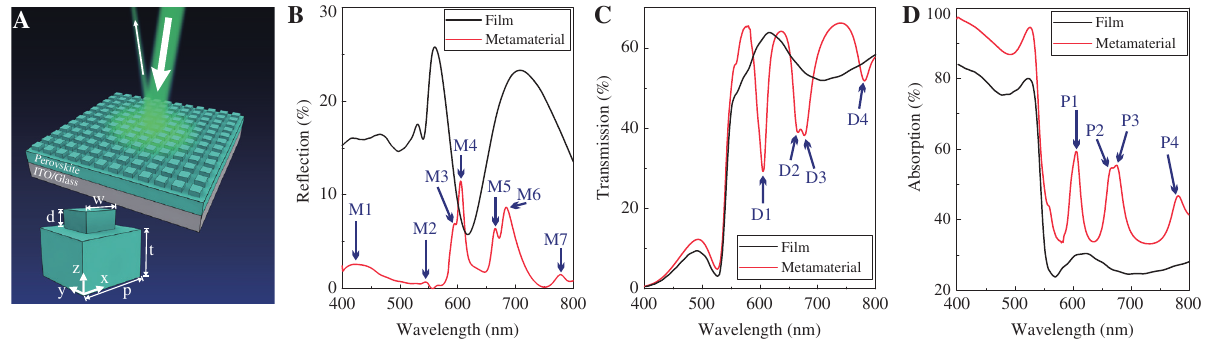
Figure 1: HOIP metamaterial and its simulated optical properties. (A) Schematic of the HOIP metamaterial. (B–D) Simulated reflection (B), transmission (C), and absorption (D) spectra of the